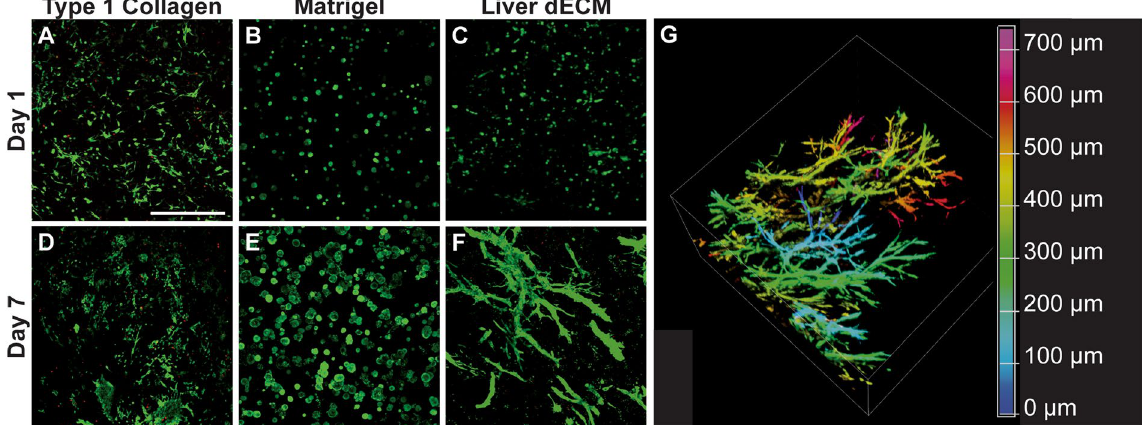
Figure 2. Cholangiocytes Encapsulated in Liver dECM Spontaneously form Duct-Like Structures. ( A – C ) Cholangiocytes encapsulated within type 1 collagen, Matrigel, or liver dECM are relatively similar after 1 day in culture. ( D – F ) After 7 days, cholangiocytes in collagen will proliferate and spread, while Matrigel cultures will form cysts, in contrast to liver dECM structures which form complex branching structures. ( G ) Duct structures will branch into complex 3-dimensional networks within thick gels over longer time periods (21 days). Color corresponds to z-depth into a confocal Z image stack. All samples are confocal z-stack maximum